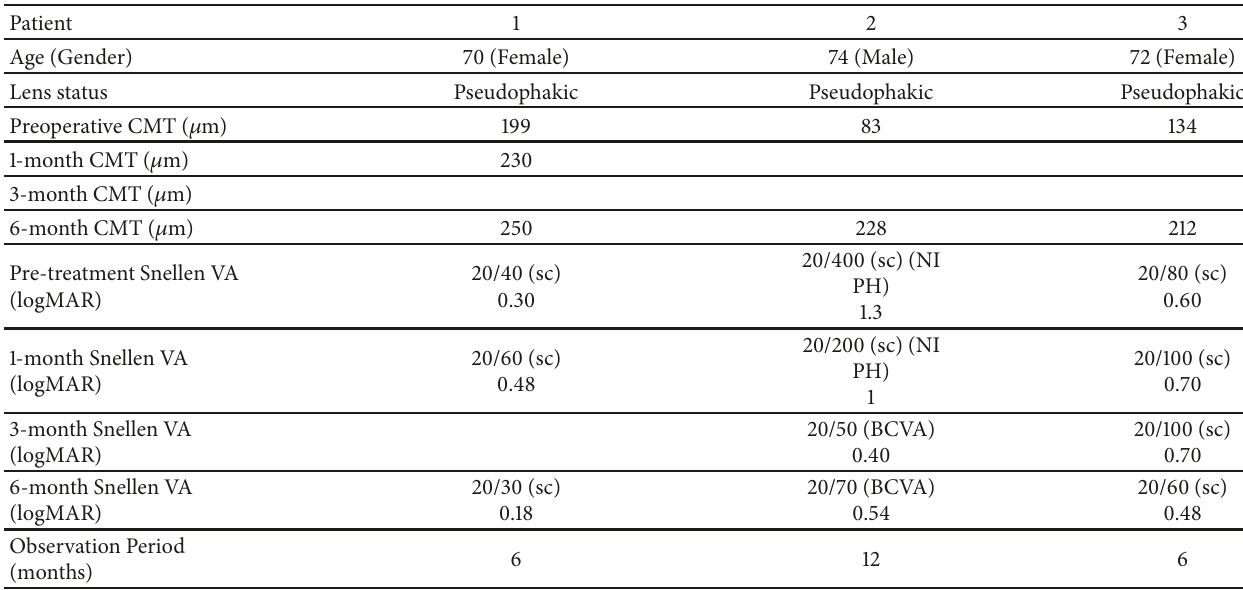
Table 1: Patient